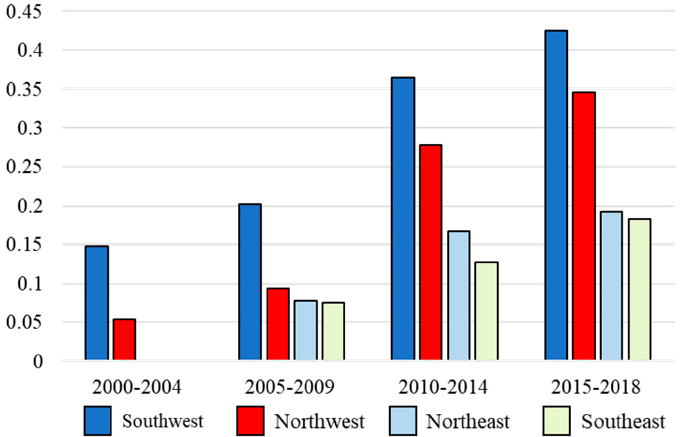
Figure 8. Evolution of the average innovation structure index of the secondary industry of the units in each area.